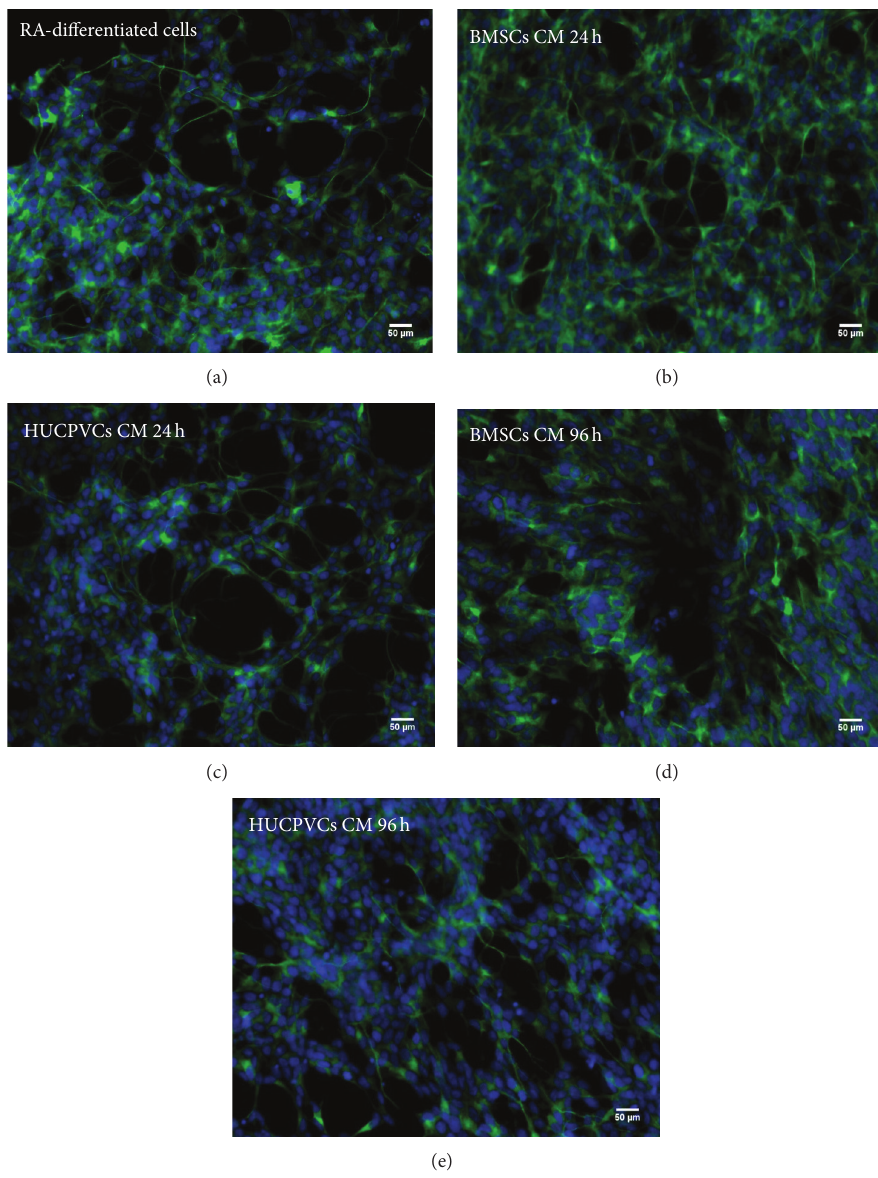
Figure 3: Fluorescence microscopy micrographs of SH-SY5Y cells immunostained with MAP-2 seven days after incubation with RA (a), BMSCs CM (24 h, 96h: (b), (d)), and HUCPVCs CM (24h, 96 h: (c), (e)). As it can be observed, the secretome of both BMSCs and HUCPVCs was able to induce SH-SY5Y cells differentiation into neuronal-like